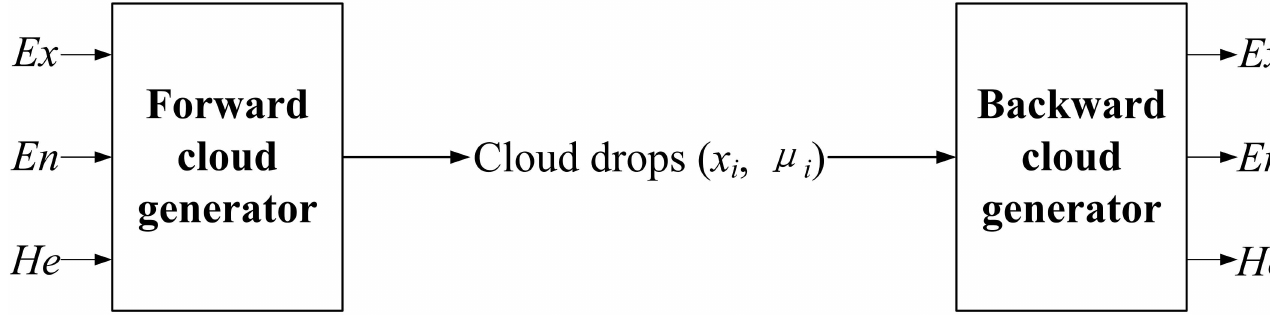
Fig 1. Cloud generator.